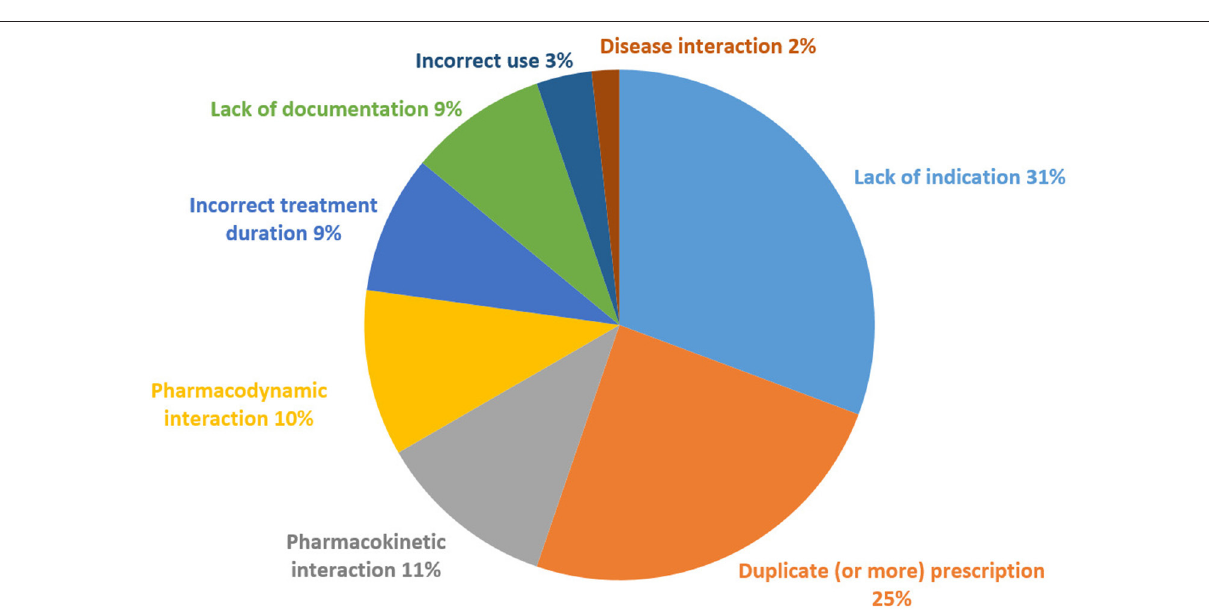
FIGURE 4 | Distribution of PIM types during all